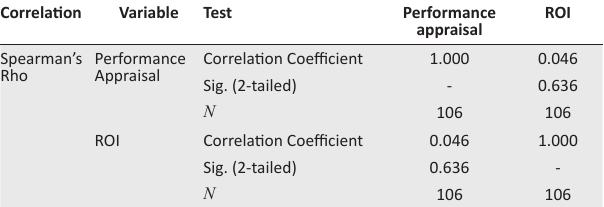
TABLE 5: Spearman’s correlation on performance appraisal versus return on